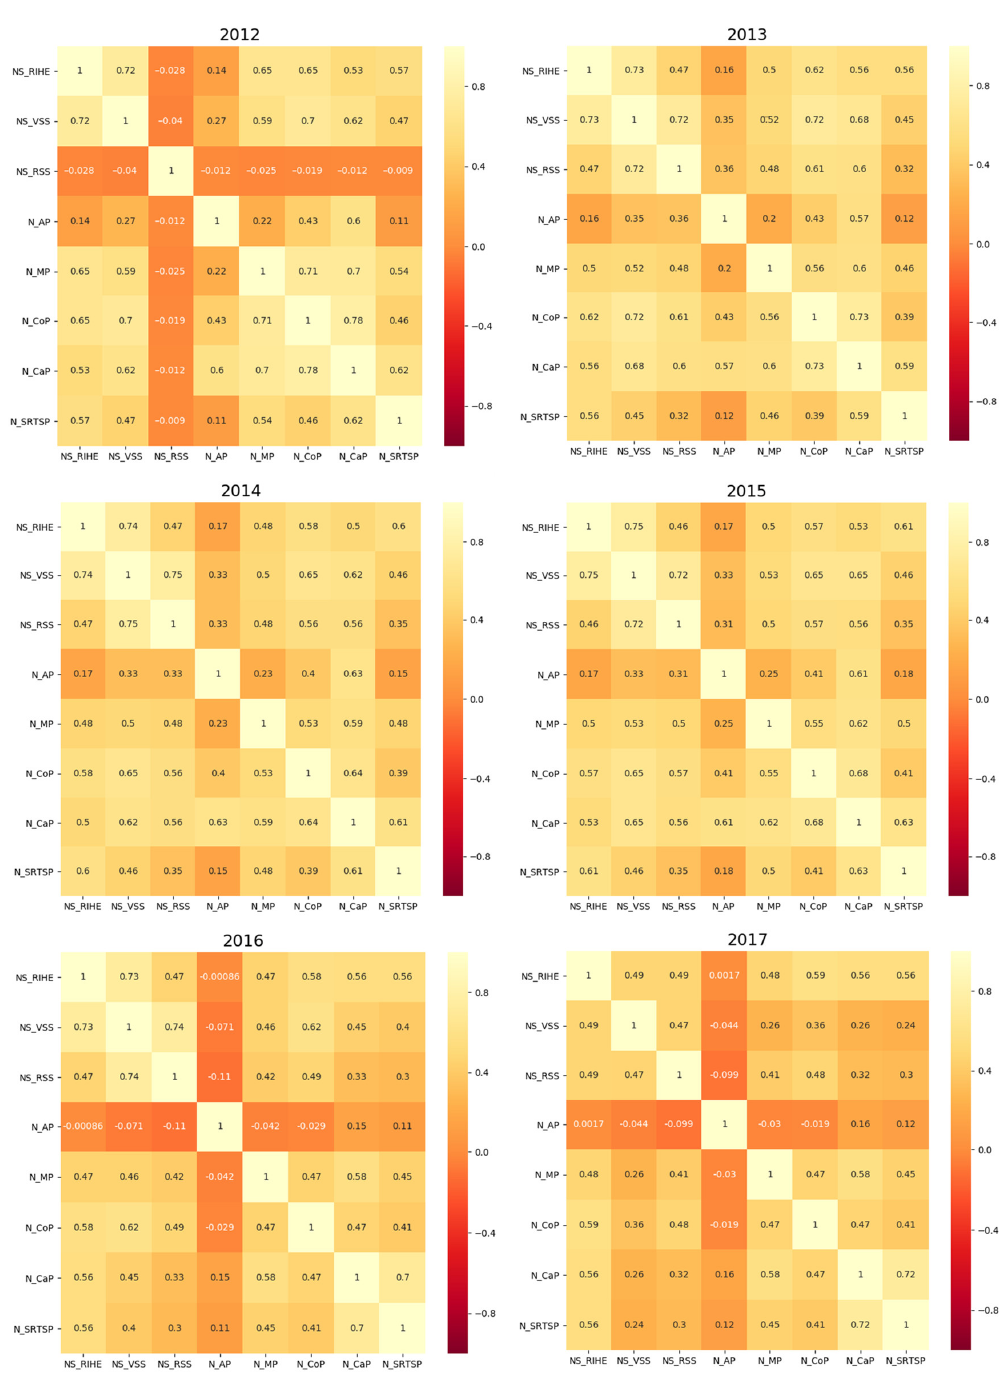
Figure 3. PCA correlation coefficient matrix. (All of the variables are the number of people